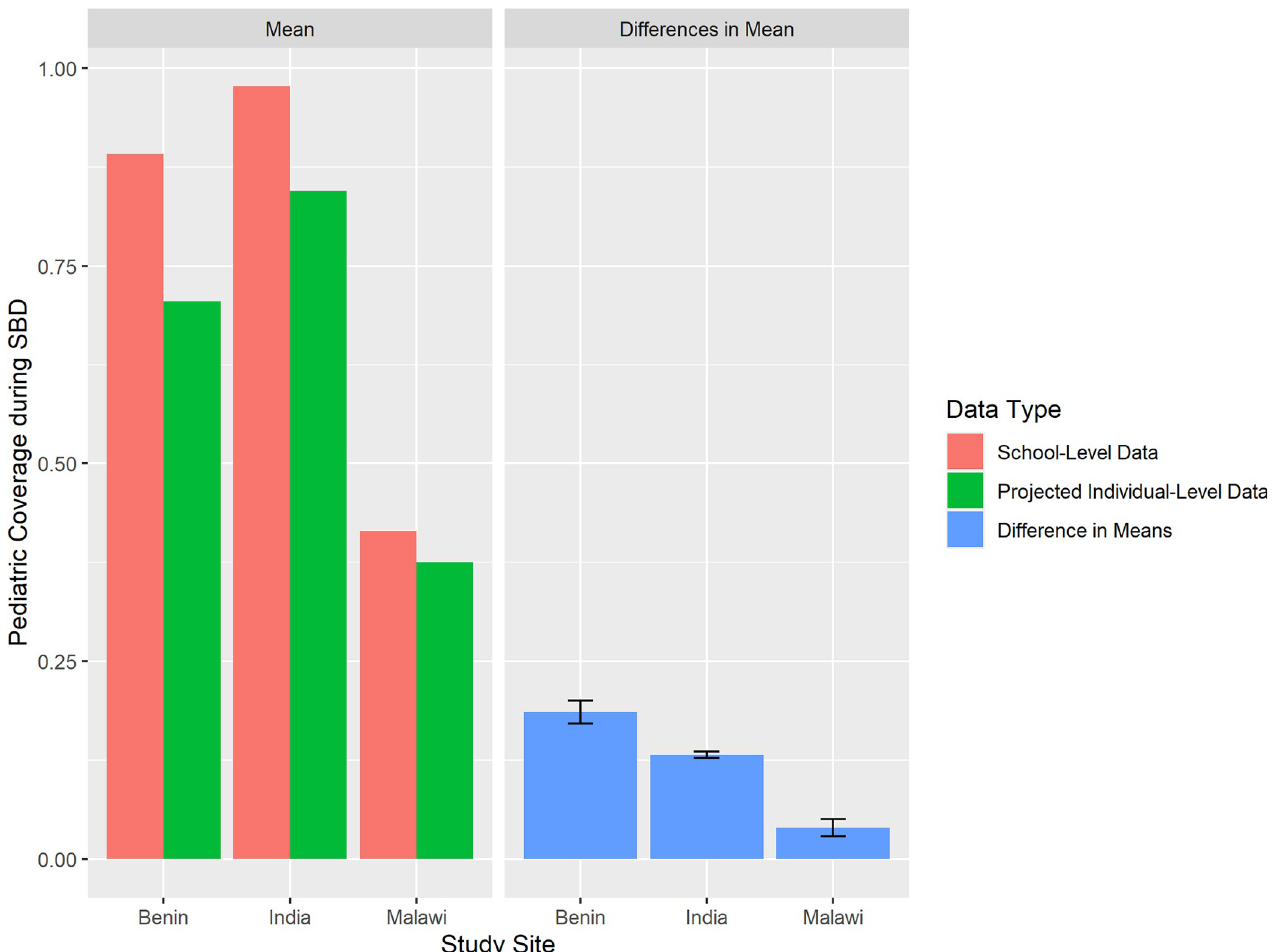
Fig 5. Comparison of school-level average SBD coverage to average individual-level SBD coverage in control clusters after application of mean-squared error rates.